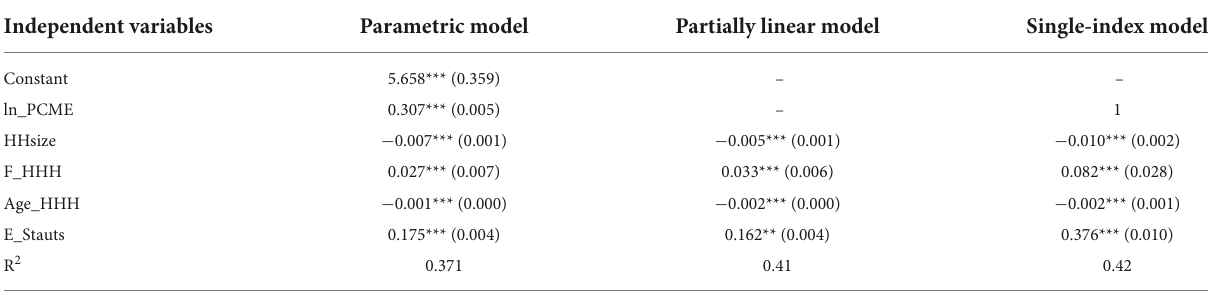
TABLE 2 Parameter estimates of parametric and semi-parametric methods. Parametric